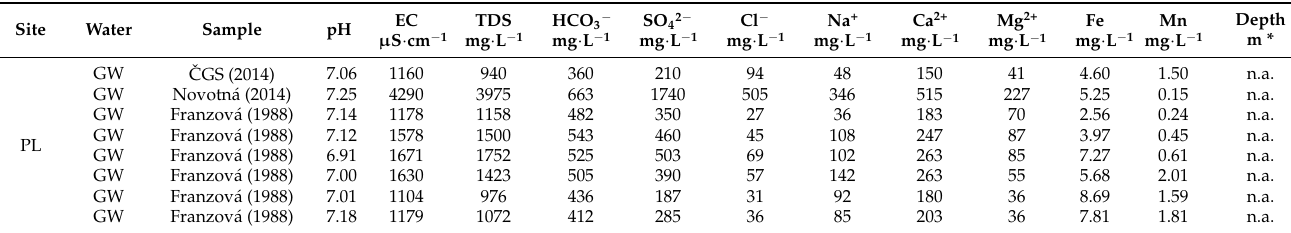
Table A1. The data on surface-water (SW) and ground-water (GW) chemistry in the area of Placek (PL) Forest Reserve and Bedrich (BE) forest; EC = electrical conductivity; TDS = total dissolved solids, and the GW level depth in the time of sampling. The legacy data are provided with references; without references are the original data of samples collected in May 2019; n.a. = not